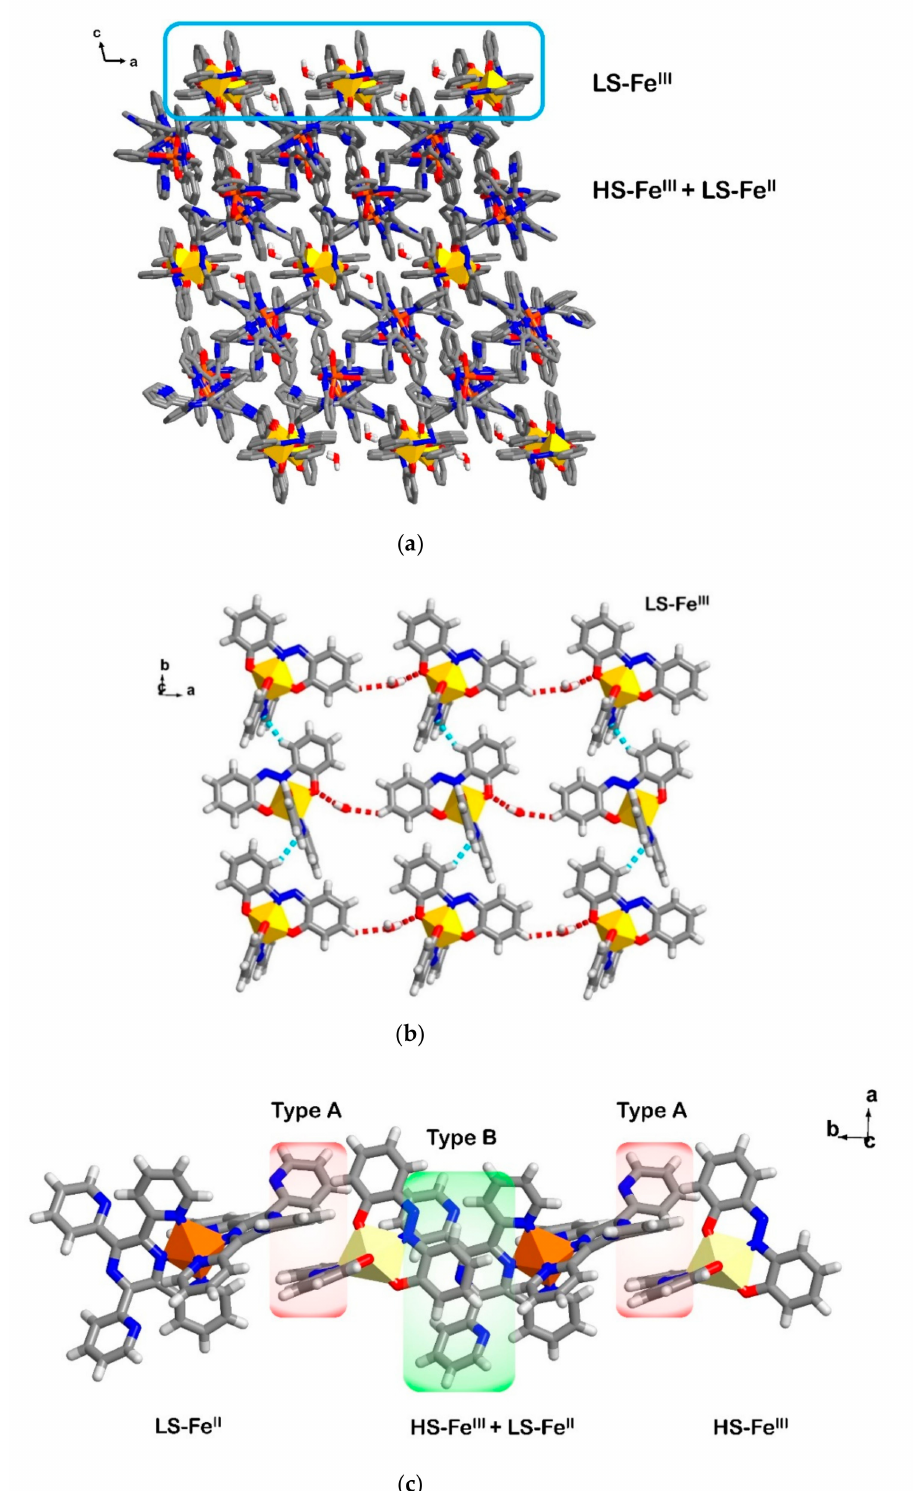
Figure 6. Crystal packing in 5 showing ( a ) the LS-Fe II and HS-Fe III molecules aligned in between another sheet of anionic LS-Fe III , ( b ) O-H ··· O (red broken lines) and C-H ··· N (blue broken lines) interactions connecting [Fe III (azp) 2 ] − moieties in the anionic sheet and ( c ) two types of π ··· π interactions linking LS-Fe II and HS-Fe III molecules into a 1D chain along the b axis. Yellow and light yellow polyhedral represent coordination sphere of a LS-Fe III and HS-Fe III , respectively. While, the orange polyhedral represents the LS-Fe II